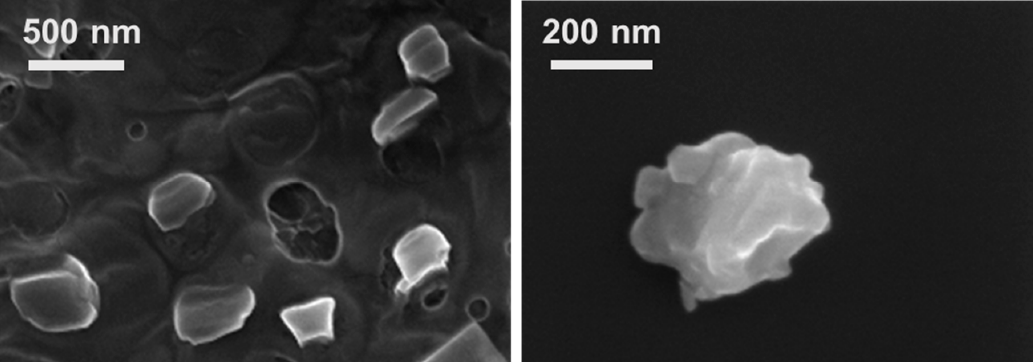
Figure 5. HR-SEM images of cellulose core-shell particles formed after the first deposition of the anionic cellulose derivative CMC onto the DDAB vesicles at 69 and 200 kx, respectively.